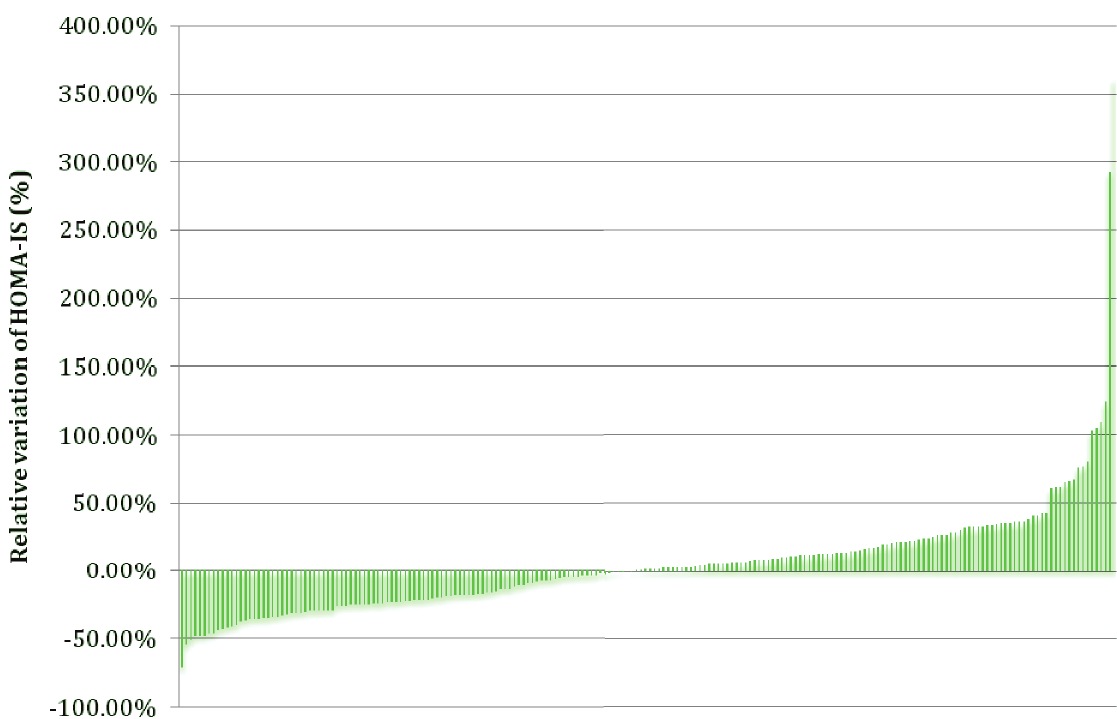
Figure 1. Inter-individual variability of HOMA-IS after a 6-week n -3 PUFA supplementation ( n =